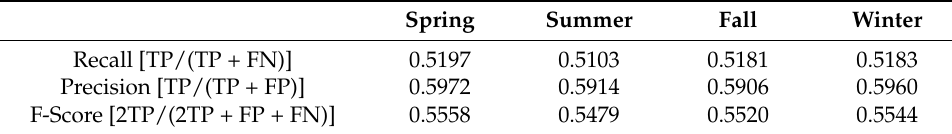
Table 4. Recall, precision and F-Score of the admission diagnosis for pneumonia.